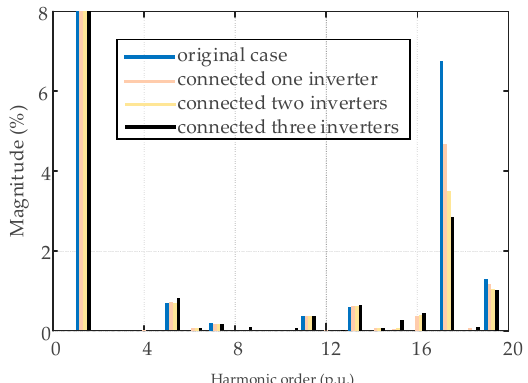
Figure 15. Voltage spectra of bus 4 connected with different numbers of inverters.